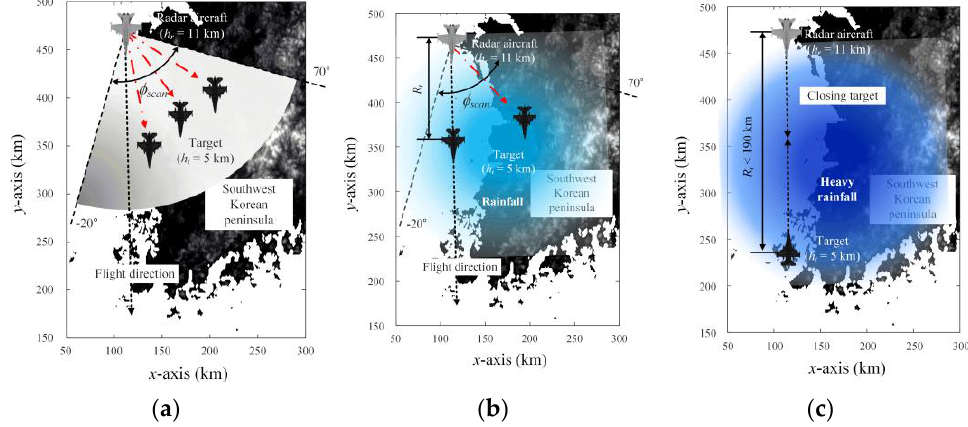
Figure 7. Three air-to-air scenarios for the TDP simulation in anomalous atmospheric environments: ( a ) azimuth beam scanning in an anomalous atmospheric environment; ( b ) azimuth beam scanning in a rainy environment; ( c ) encountering a target in a heavy rain environment.